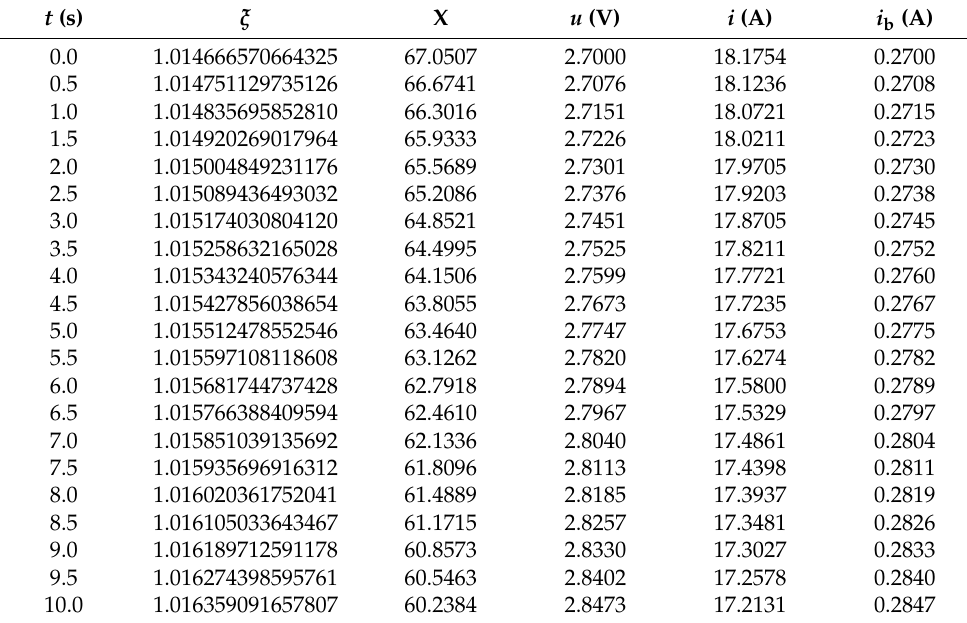
Table 4. Numerical results calculated in SC charging, R b = 10 Ω